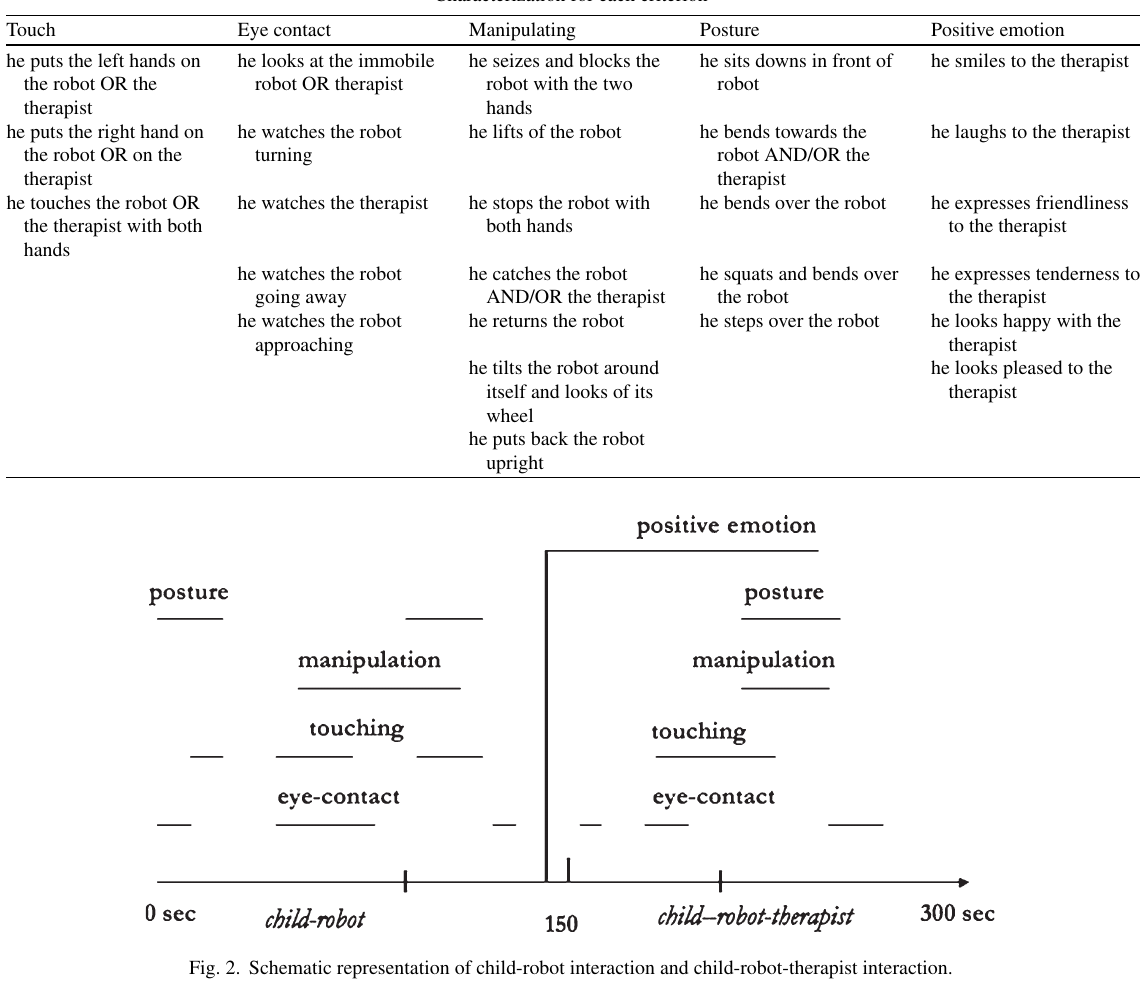
Table 1 Characterization for each criterion